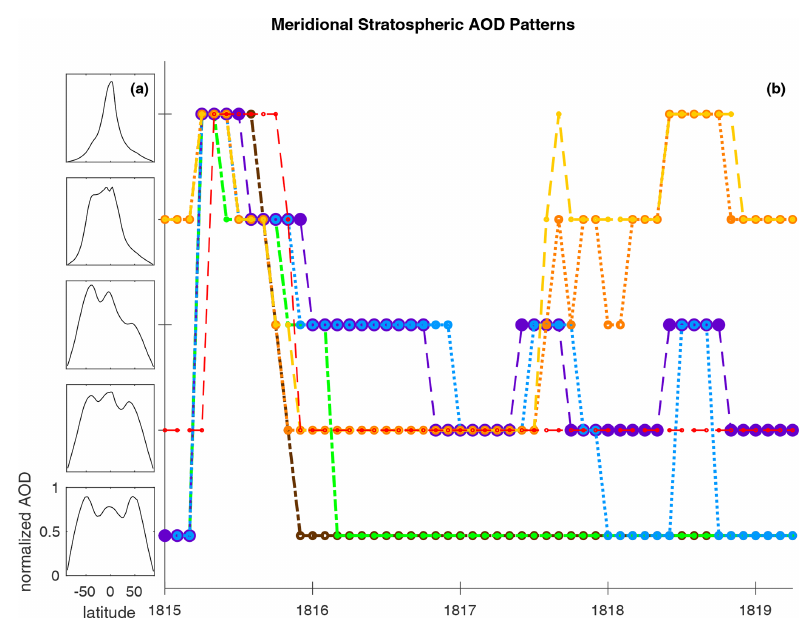
Figure D1. Time evolution of stratospheric meridional circulation patterns of aerosol in terms of AOD. (a) The five most representative characteristic patterns of normalized zonally averaged AOD as a function of latitude. The five patterns of (a) make up the y axis of (b) , which is the time evolution of each model in terms of which of the five characteristic meridional normalized AOD profiles it best matches at each month. Colors correspond to the ensemble mean of the five ensemble runs from CESM-WACCM (blue), UM-UKCA (purple), SOCOL-AER